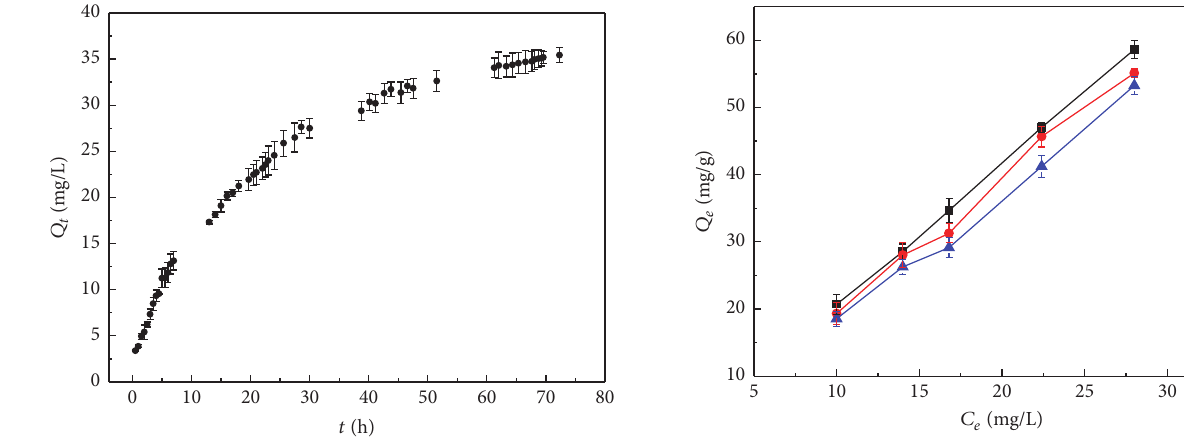
Figure 7: Adsorption capacity of CA4 for methyl orange with concentration of 30mg/L at 25 ∘ C as a function of time.